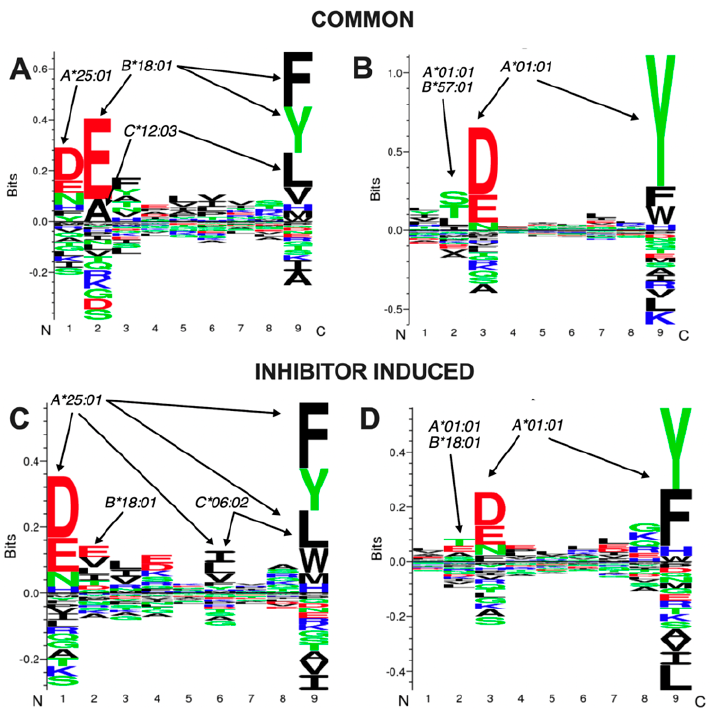
Figure 4. Weblogo type plots based on Gibbs cluster analysis of 9mer sequences of identified peptides. Analysis was performed using the GibbsCluster-2.0 Server and plotted using the Seq2logo server. Amino acids are colored based on their physicochemical properties (negatively charged = red, positively charged = blue, hydrophobic/aromatic = black, hydrophilic = green). The size of the letter representation of each amino acid single letter code indicates the probability of observation at the particular position of each cluster. Positive value on the y-axis suggests a higher-than-random prevalence of the particular residue at that position. Positions that show the enhanced presence of residues that correspond to anchor residues of particular HLA alleles are indicated with arrows. Panels ( A , B ) indicate the two major clusters observed for peptides common in both control and inhibitor conditions and panels ( C , D ) indicate the two major clusters observed for peptides unique in the inhibitor-treated